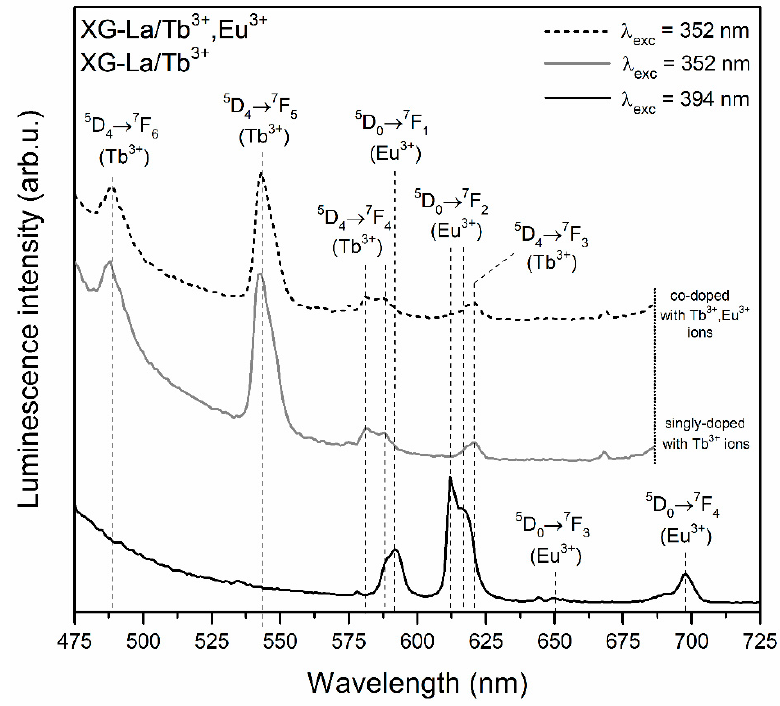
Figure 5. PL spectra of XG-La / Tb 3 + and XG-La / Tb 3 + ,Eu 3 + samples recorded upon NUV illumination at λ exc = 352 nm and λ exc = 394 nm.